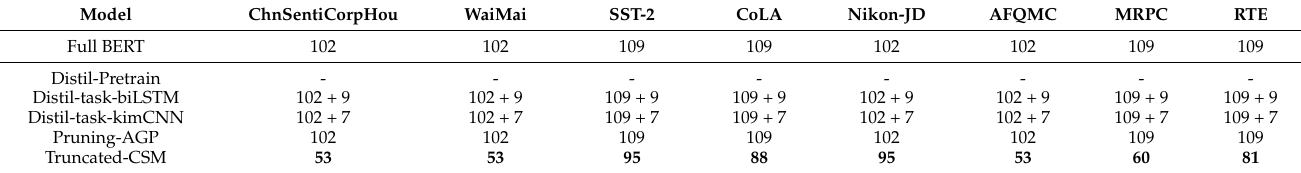
Table 6. Number of parameters in the model needs to be stored and updated during training/fine- tuning for the 8 BTC tasks in this study. All values have been scaled by 1M. Bold denotes the smallest values. The quantity of Distil-Pretrain is not available, and thus also not shown in the table. The quantity of a distillation based model counts the parameters in both the teacher and student.